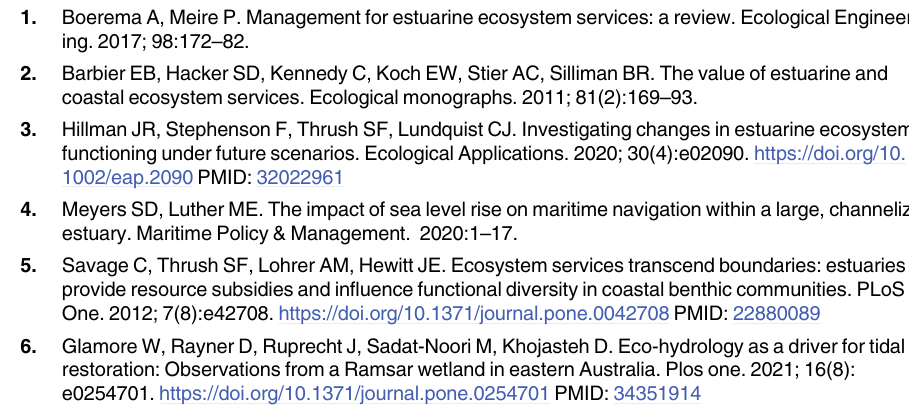
S12 Table. A summary of estuarine tidal range responses to SLR during high river